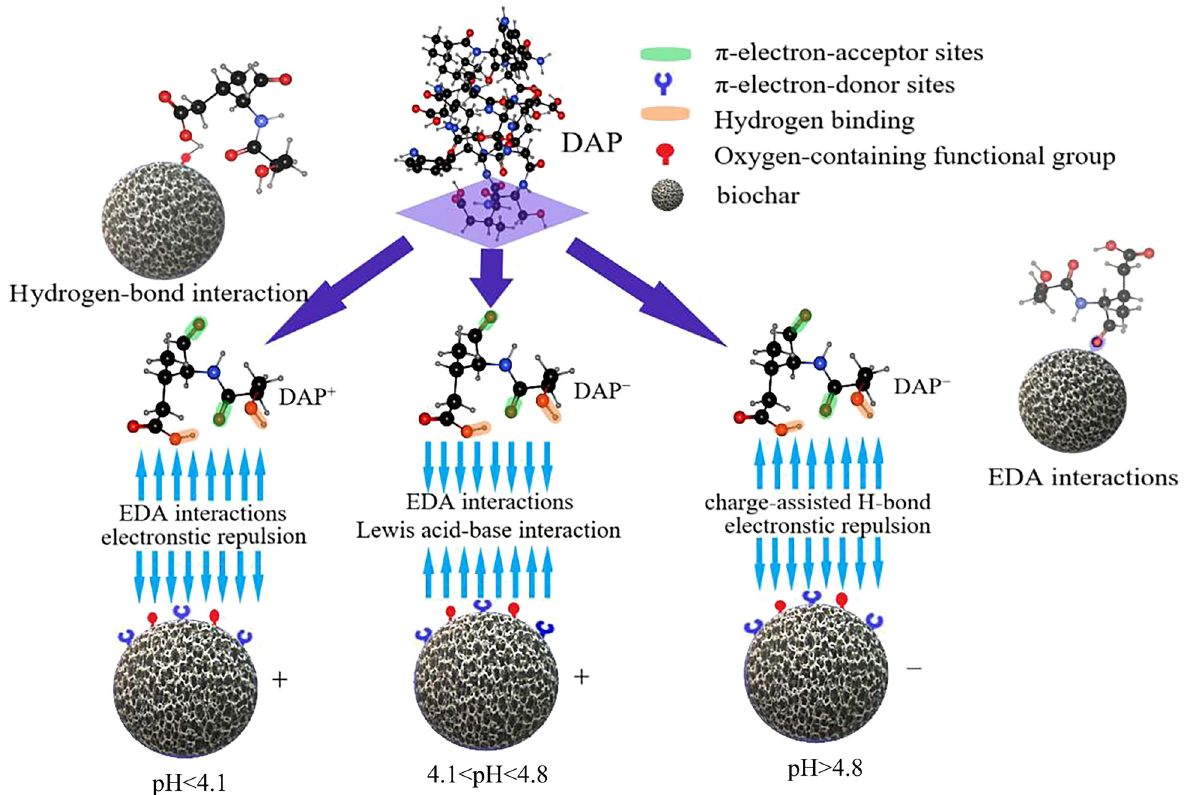
Figure 7: Mechanism of AF - biochar adsorbing DAP.